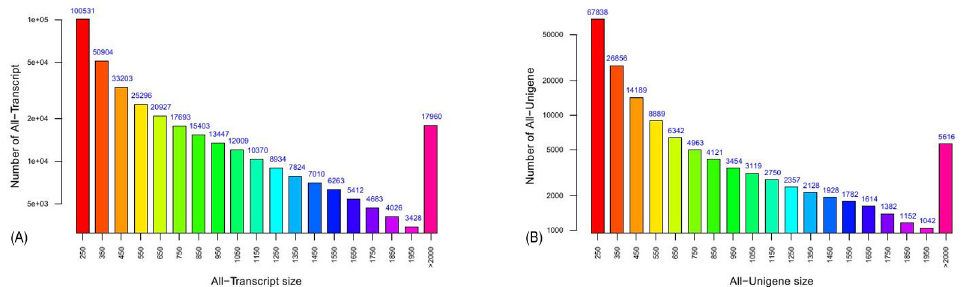
Fig 1. Overview of the chrysanthemum transcriptome sequencing. (A) Length distribution of chrysanthemum all-transcript. (B) Length distribution of chrysanthemum all-unigene.